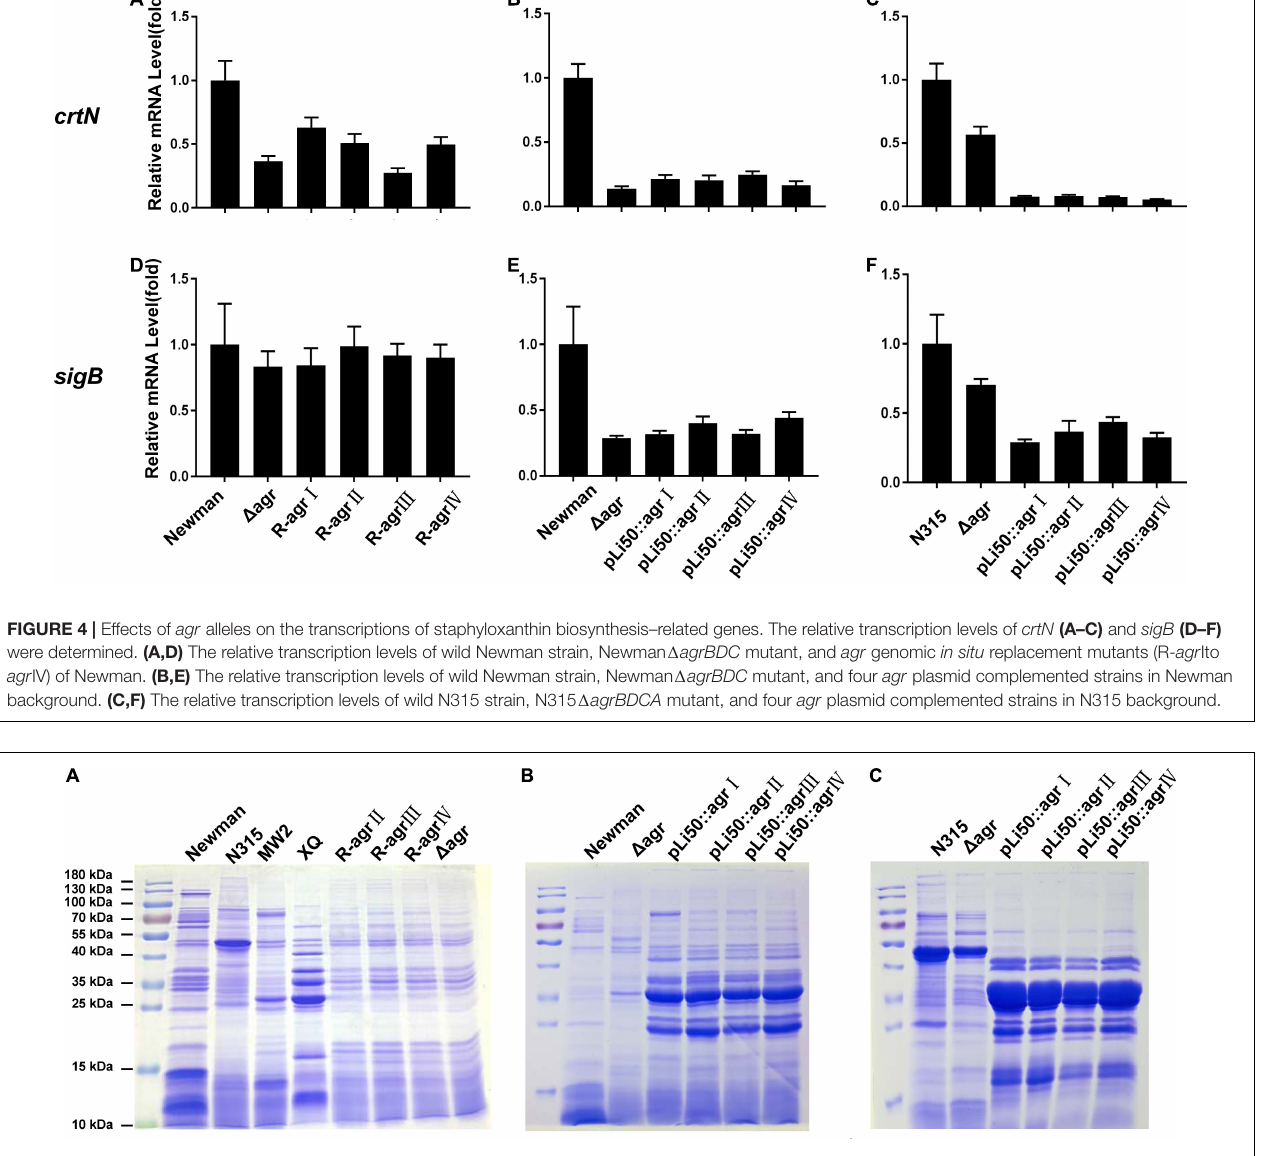
FIGURE 5 | Effects of agr alleles on the exoprotein productions of S. aureus . Overnight culture supernatants of S. aureus strains were collected and analyzed with SDS-PAGE. (A) Exoprotein profiles of the four wild agr allelic strains ( agr I/Newman, agr II/N315, agr III/MW2, and agr IV/XQ), Newman (cid:49) agrBDC mutant and three agr genomic in situ replacement strains in Newman background. (B) Exoprotein profiles of wild Newman strain, Newman (cid:49) agrBDC mutant, and four agr plasmid complemented strains in Newman background. (C) Exoprotein profiles of wild N315 strain, (cid:49) agrBDCA -N315 mutant, and four agr plasmid complemented strains in N315